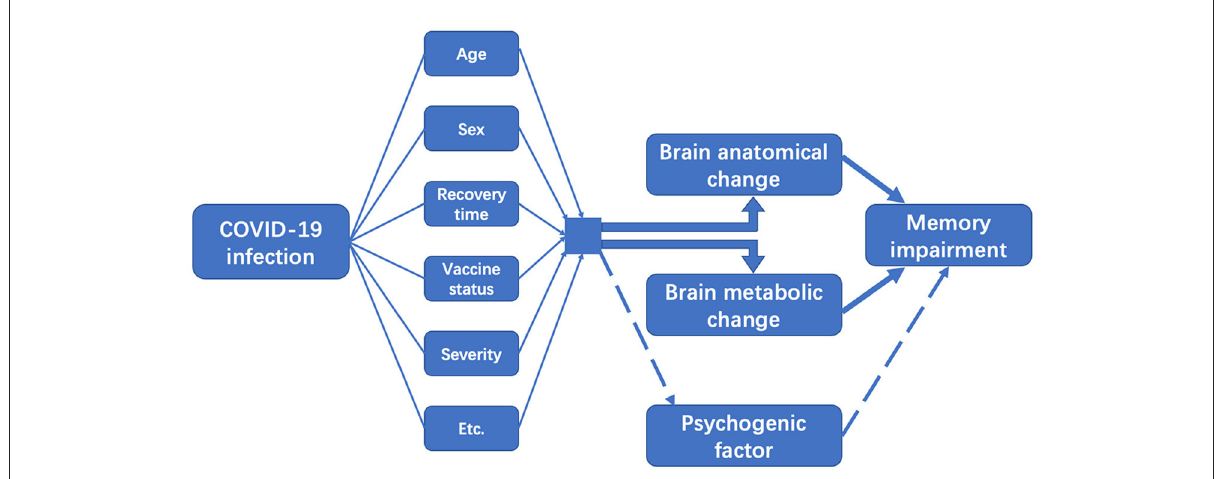
FIGURE2 Schematic representation of memory impairment after COVID-19